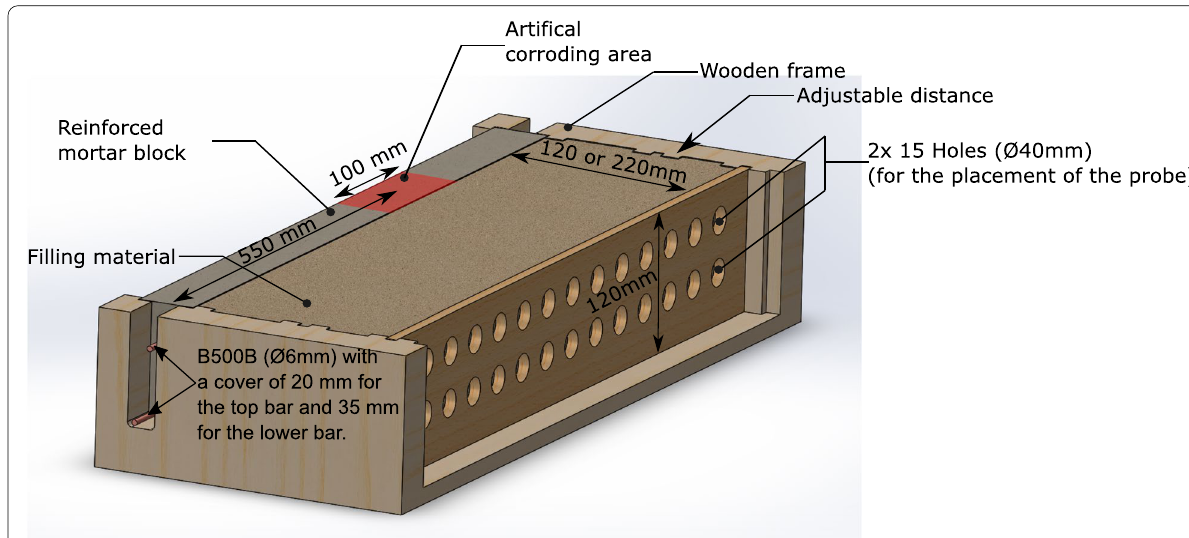
Fig. 7 Sketch of the laboratory setup with the adjustable distance between the mortar surface and the position of the reference electrode indicated by two rows of 15 holes (Ø 40 mm) and the location of the artificially introduced corrosion location on the reinforced mortar block with = two steel bars B500B and its